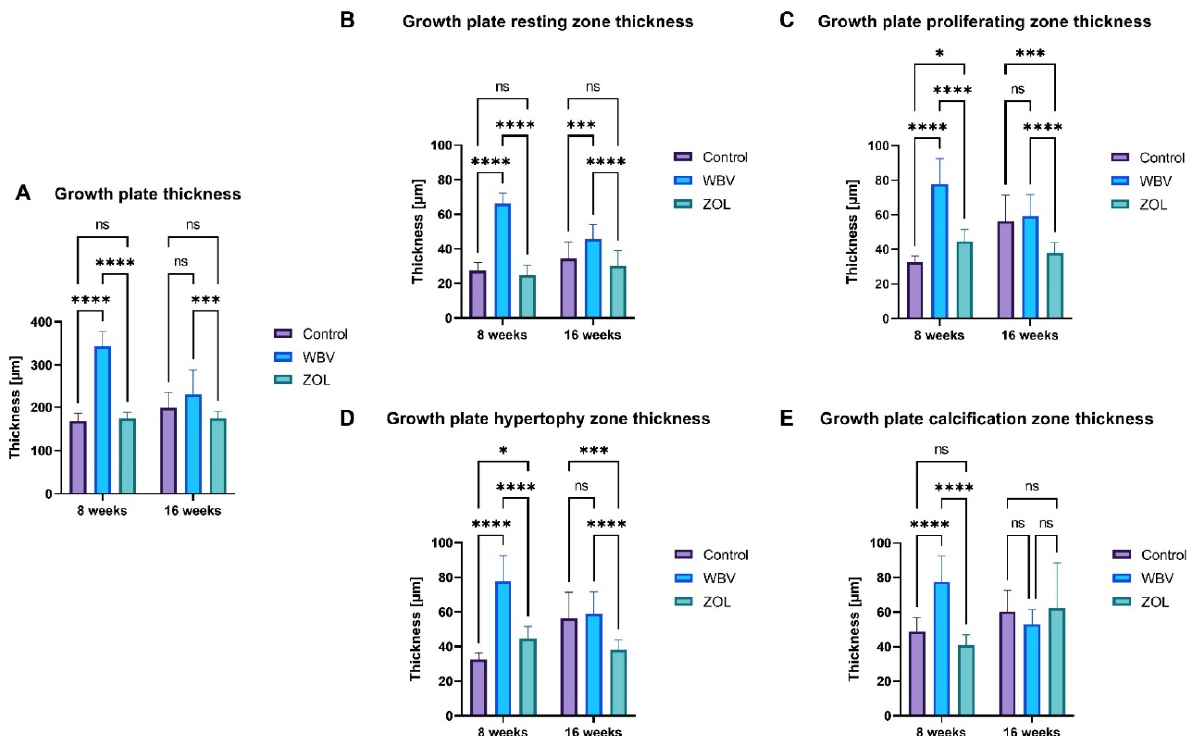
Figure 2. The effect of whole ‐ body vibration (WBV) or zoledronic acid (ZOL) supplementation on the thickness of zones in the growth plate cartilage in rats subjected to obesity and immobility: ( A ) total growth plate thickness; ( B ) resting zone; ( C ) proliferating zone; ( D ) hypertrophy zone; ( E ) calcification zone. Control—the control group included rats subjected to obesity and immobility not treated with WBV or ZOL; WBV—the WBV group included rats subjected to obesity and immobility with whole ‐ body vibration treatment (30 min, 5 days per week); ZOL—the ZOL group included rats subjected to obesity and immobility and injected intramuscularly with zoledronic acid at a dose of 0.025 mg/kg body weight every 4 weeks. Data are mean values ±SD from n = 6 rats. Statistical significance: ns—not significant; * p < 0.05; *** p < 0.001; **** p < 0.0001 (Tukey’s HSD test or Kruskal–Wallis H test).